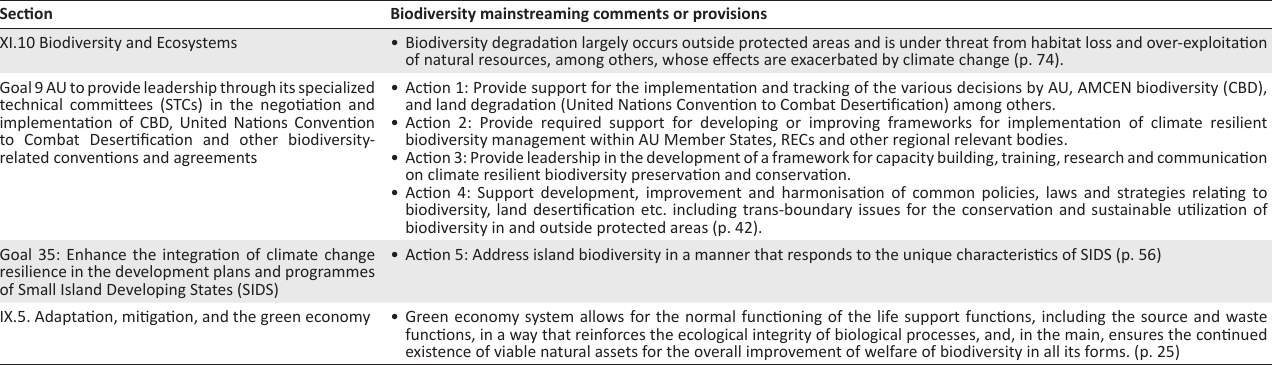
TABLE 3: Summary of biodiversity mainstreaming in African climate change